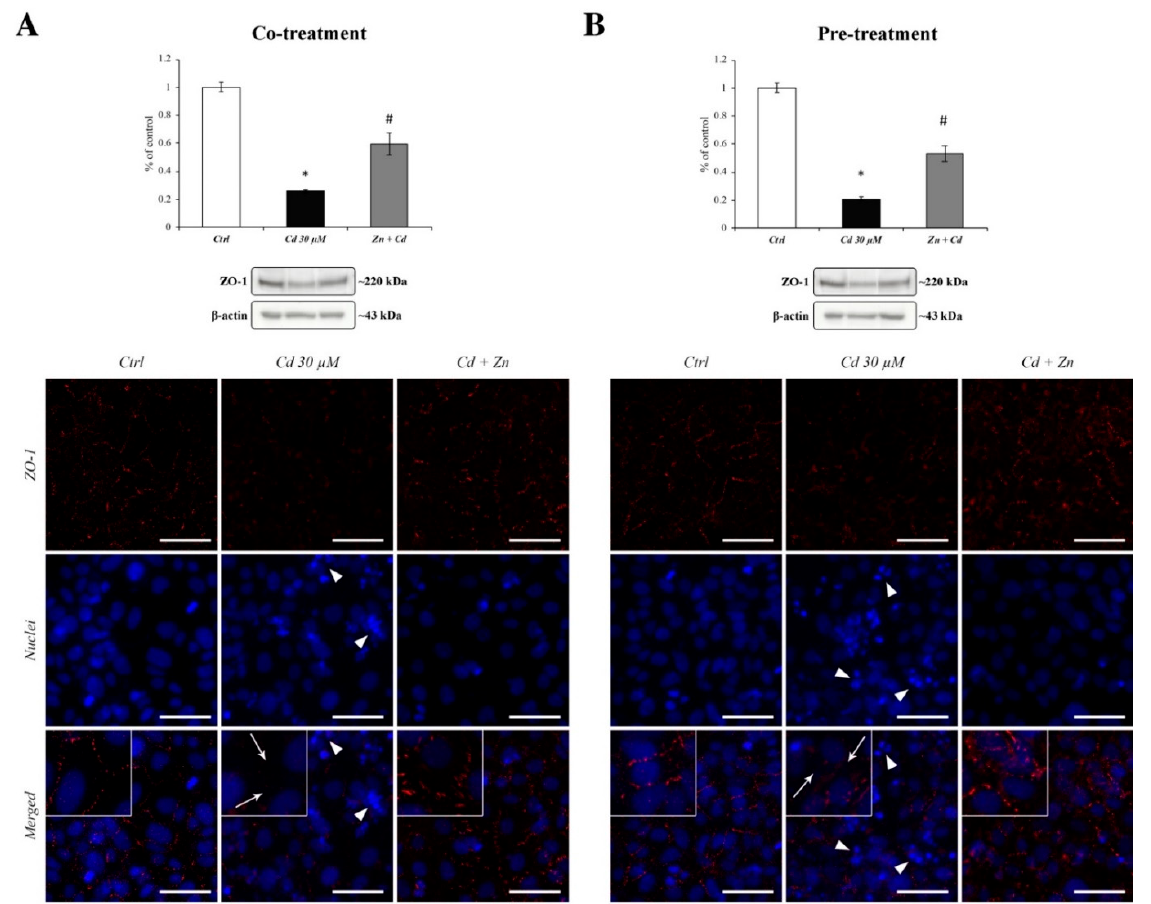
Figure 8. ZO-1 alterations on RBE4 cell monolayer during CdCl 2 and ZnCl 2 exposure. Histograms show a strong decrease in ZO-1 expression in Cd 30 µ M (black bars) treated cells, which was counteracted both during co- and pretreatment with Zn 50 µ M (grey bars). Representative images showing the immunofluorescence staining of ZO-1 (red) and nuclei (blue) during cotreatment ( A ) and 24 h pretreatment ( B ) regimens. Inserts show slightly enlarged view of parent images, illustrating the Cd-dependent formation of holes (white arrows) in the ZO-1 cellular distribution and the nuclear alteration (white arrowhead). Total magnification: 400 × . Scale bar: 50 µ m. * p < 0.05 vs. Ctrl; # p < 0.05 vs. Cd treatment.